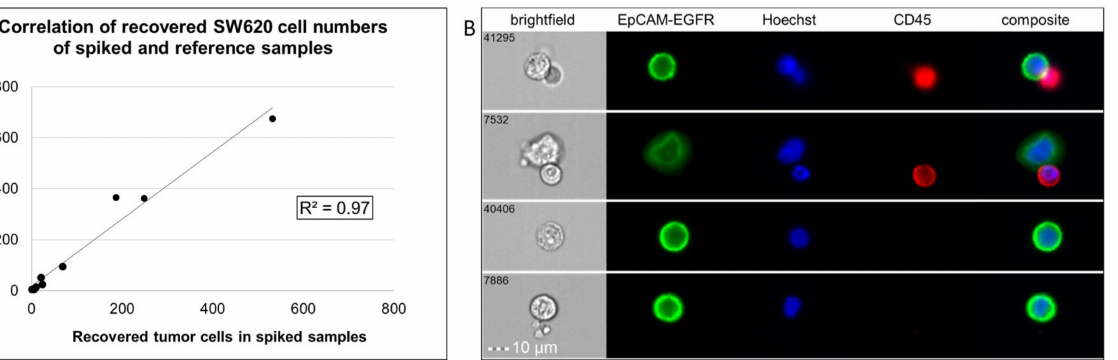
Figure 1. Gating strategy for CTC detection. At first, speedbeads and debris are excluded. Hoechst staining intensity of the gated events is displayed in a 2D plot. Hoechst positive nucleated cells (blue) are then separated by their fluorescence intensities for EpCAM–EGFR–AF488 and CD45–AF647. CTCs are defined as Hoechst positive /CD45 negative /EpCAM–EGFR positive . Single CTCs are detected in the CD45 negative /EpCAM–EGFR positive gate (green), whereas cluster of leukocytes and CTCs are detected in the CD45 positive /EpCAM–EGFR positive gate (purple).